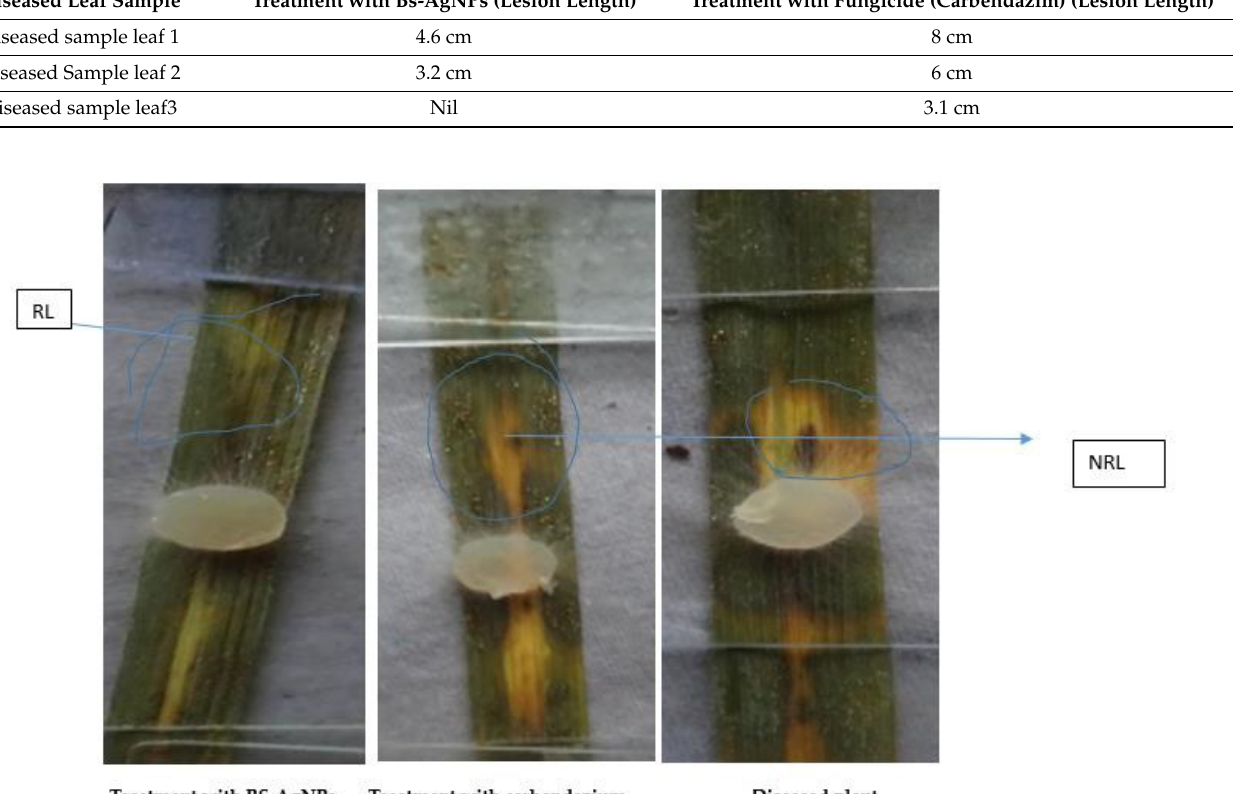
Figure 13. Leaves affected by sheath blight disease treated with Bs-AgNPs or carbendazim, exhibiting a reduction or increase in lesion length, respectively, highlighting the potential application of Bacillus -mediated silver nanoparticles as a nano fungicide. RL, reduced lesion; NRL, no reduction in lesion.